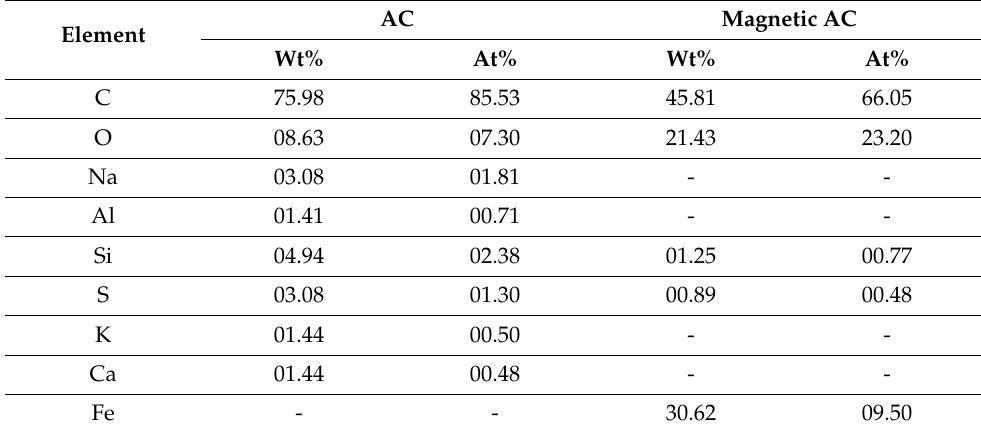
Table 1. Elemental composition of tire waste-derived AC and